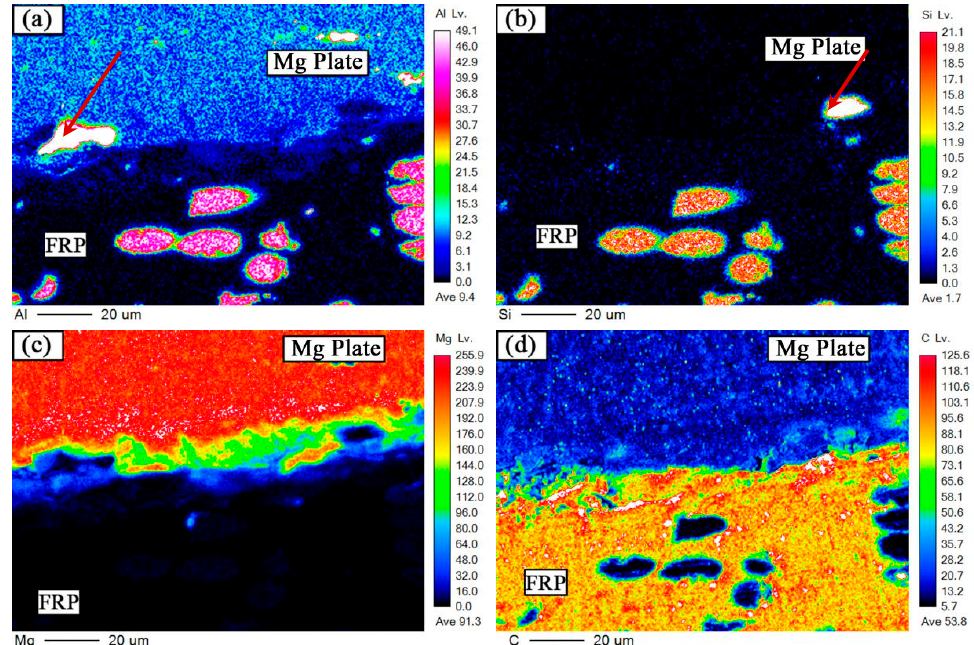
Figure 9. EPMA of the C region in Figure 5d. Elements distribution of ( a ) Al, ( b ) Si, ( c ) Mg, and ( d ) C.